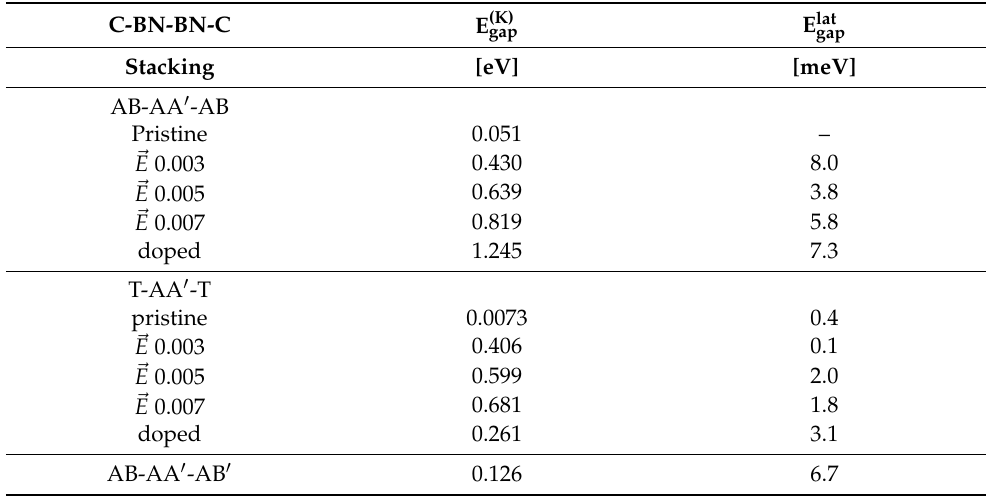
Table 4. Electronic gaps at K for the quadrilayers. In addition, the values of the small lateral gaps E lat gap are reported. Electric field strengths are in a.u.